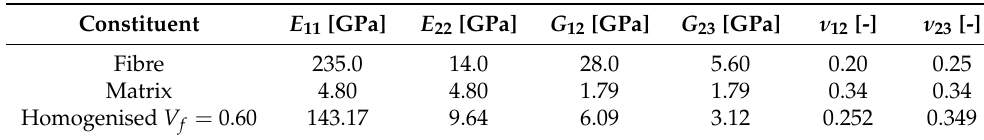
Table 2. Elastic properties of the constituents of the composite material and the homogenised material properties for a fibre volume fraction V f = 0.60.